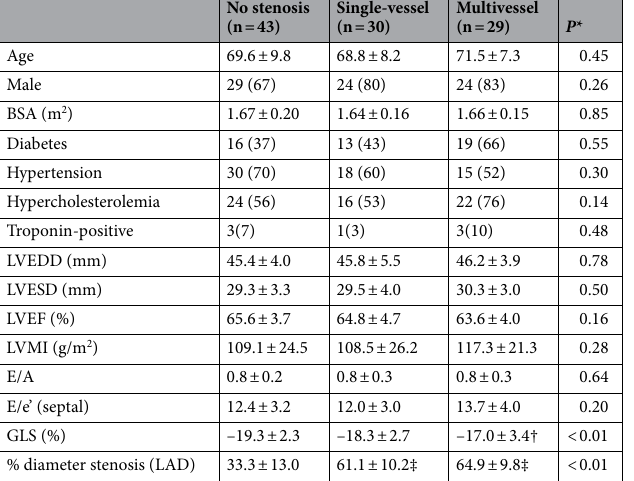
Table 1. Patient characteristics. Data are presented as mean ± standard deviation or n (%). BSA, body surface area; GLS, global longitudinal strain; LAD, left anterior descending artery; LVEDD, left ventricular end- diastolic dimension; LVEF, left ventricular ejection fraction; LVESD, left ventricular end-systolic dimension; LVMI, left ventricular mass index. * P derived from the analysis of variance or the Kruskal–Wallis test, † P < 0.05 versus no stenosis, ‡ P < 0.01 versus no